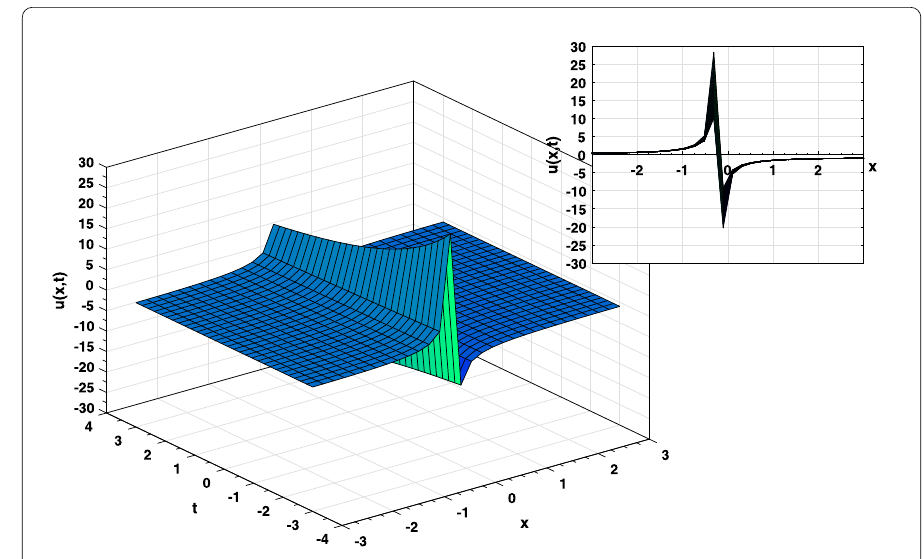
Figure 2 Exact solution u 2 ( x , t ) of Eq. (2) by substituting the values λ = 0.834, μ = 1, α = 0.8, –3 ≤ x ≤ 3, –4 ≤ t ≤ 4, γ = 1 for the 2D